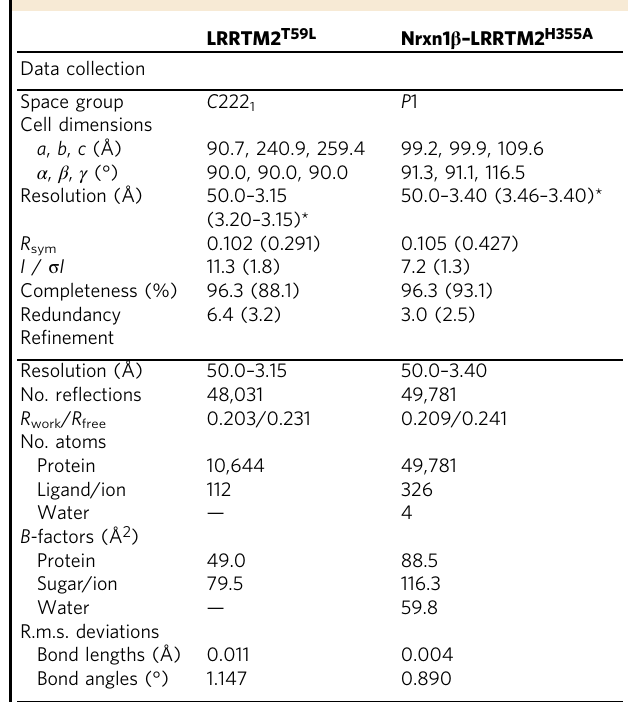
Table 1 Data collection and re fi nement statistics